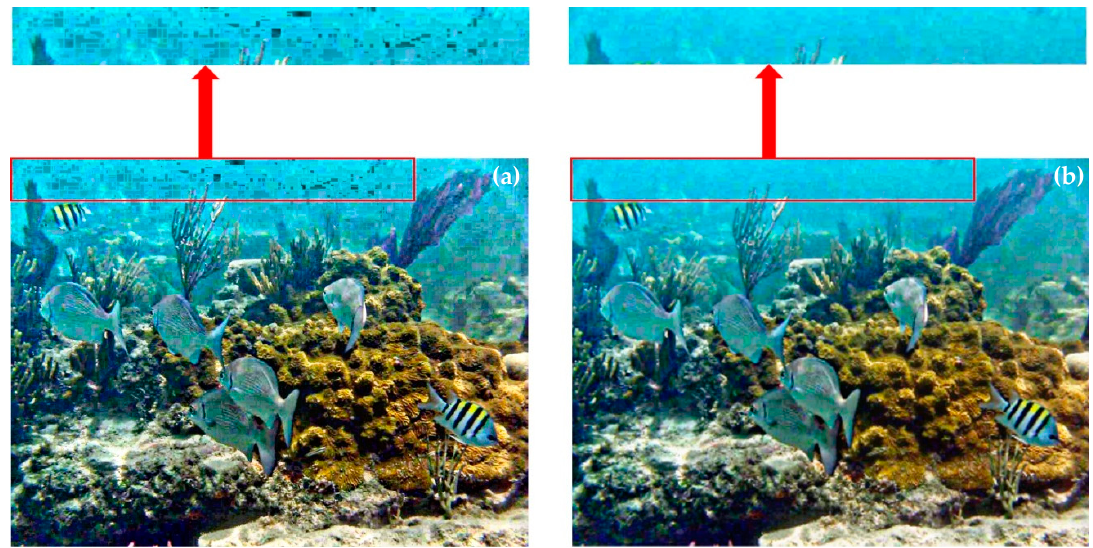
Figure 5. Output image using ( a ) weighted addition and ( b ) multi-scale fusion.